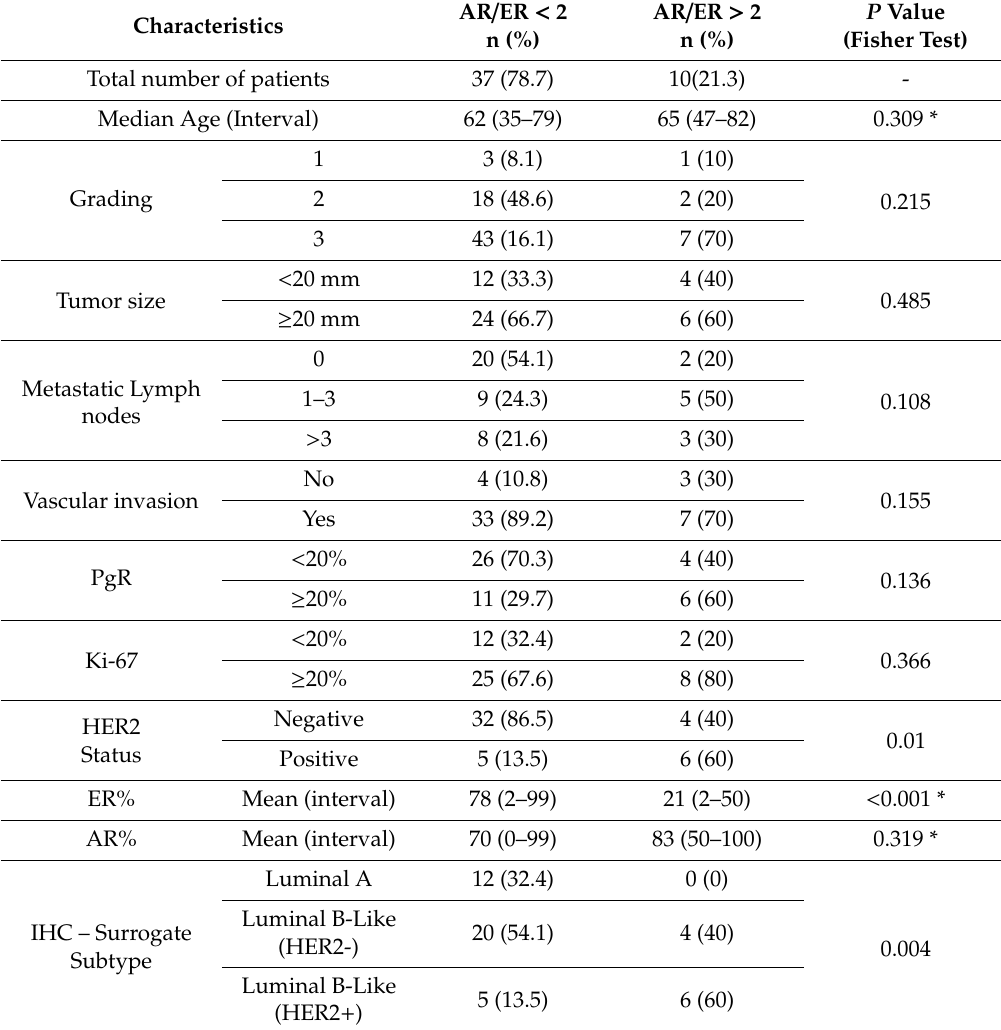
Association of AR / ER ratio with clinico-pathological characteristics of ER + cases. Classification by AR / ER ratio of ER + cases was concordant using both IHC and qPCR methods. AR: androgen receptor; ER: estrogen